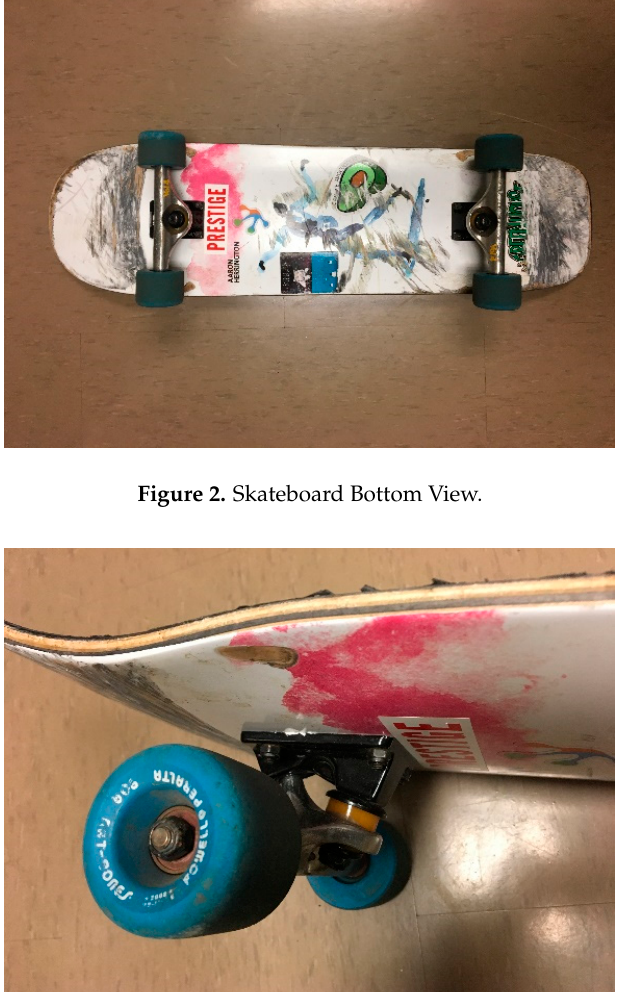
Figure 3. Skateboard Front Left Wheel.